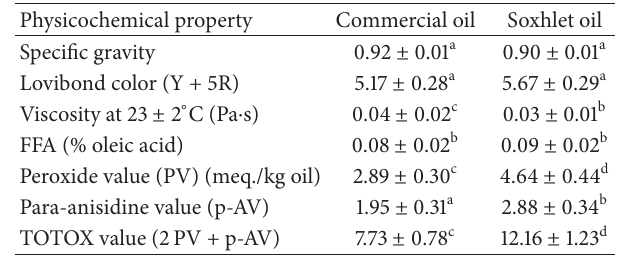
Table 1: Proximate composition of coconut copra ( West coast tall variety).